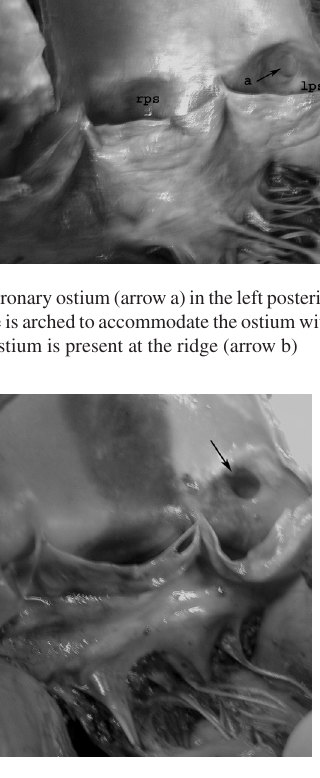
Figure 4 - The left coronary ostium (arrow) above the level of the sinutu- bular ridge